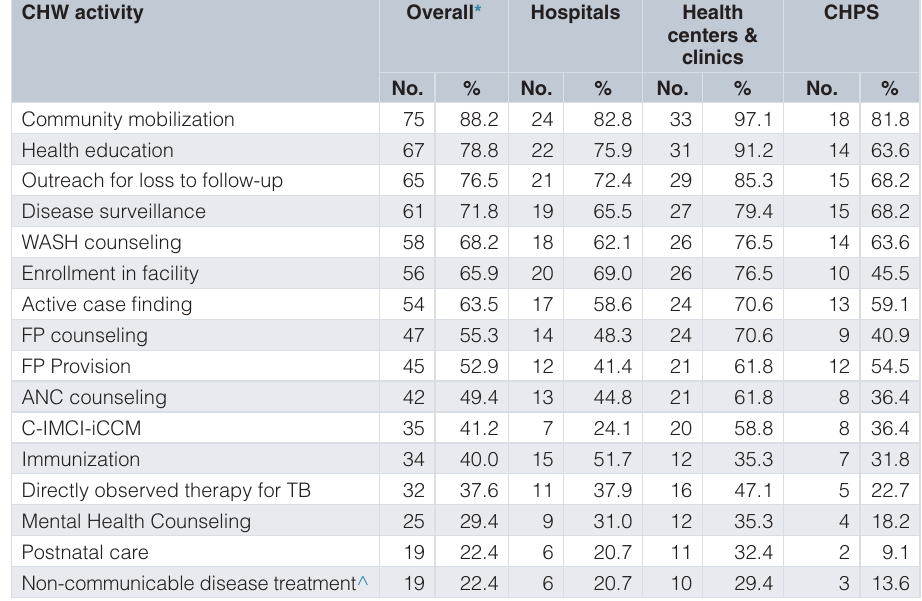
Table 8. Community health worker (CHW) activities by facility